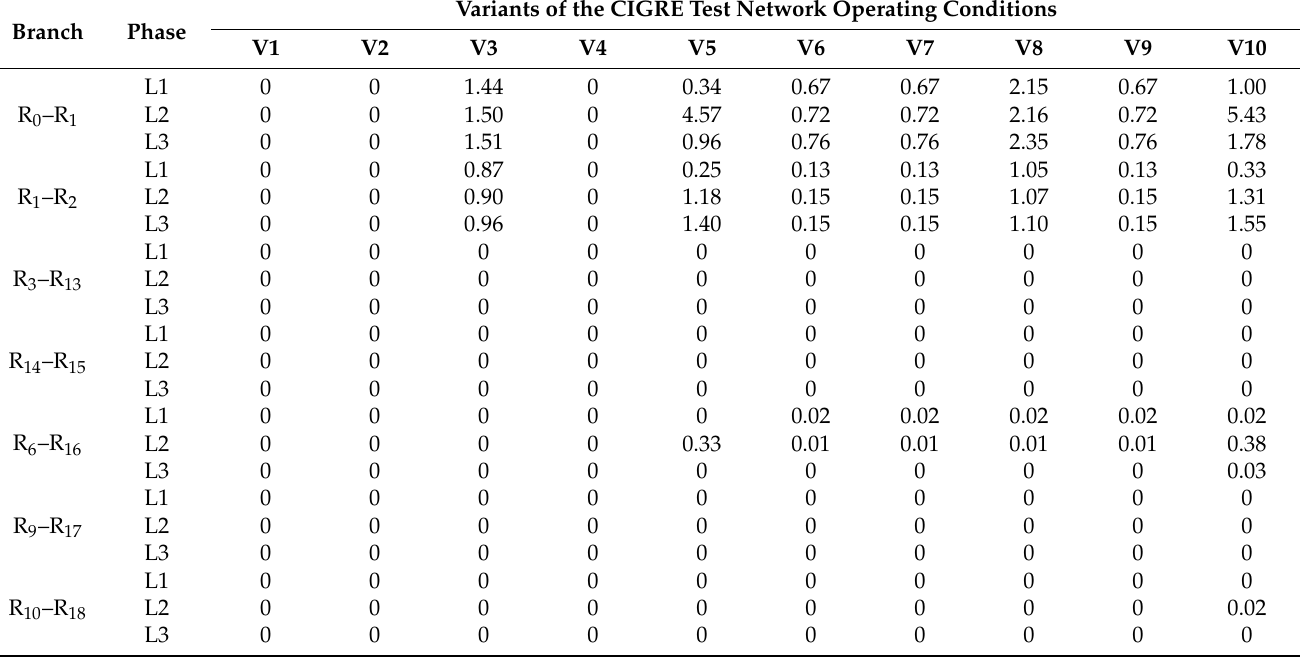
(%) in the CIGRE test network. I